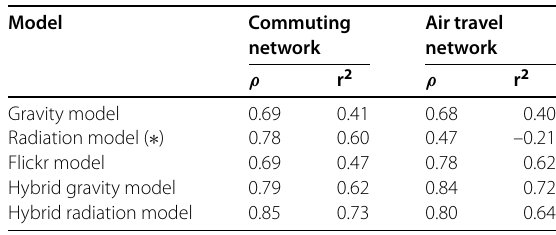
Table 1 Cross-validated model performance (10-fold